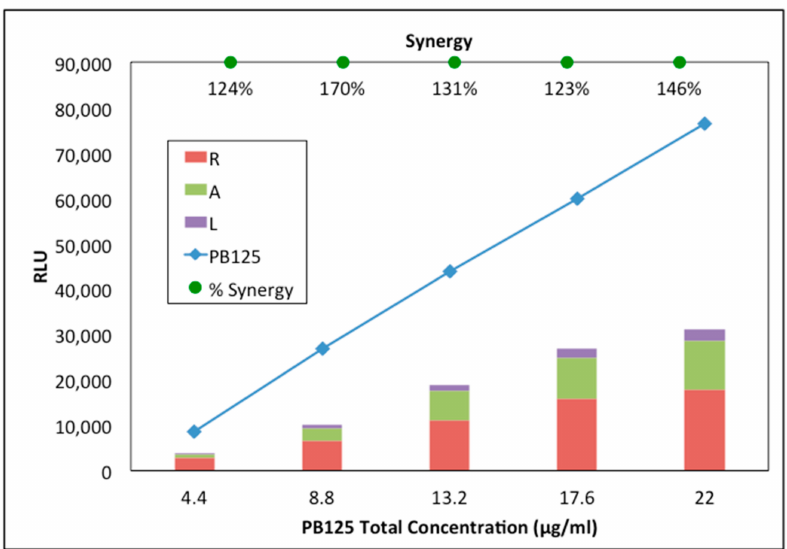
Figure 1. Synergistic activation of the Nrf2 pathway by the components in PB125. Synergy between the components of PB125 was observed measuring the relative light units (RLU) of chemiluminescence observed with added luciferin after ARE-driven luciferase gene expression was induced by treatment with range of concentrations of PB125 in the HepG2 (human liver) cancer cell line stably transfected with an ARE-driven luciferase gene as a promoter-reporter construct [84]. The individual contributions of the rosemary (R), ashwagandha (A), and luteolin (L) at the same concentration as in the 15:5:2 by mass combination of the same ingredients did not add (stacked bars) to as high of an RLU reading (Nrf2-dependent expression of the luciferase gene) as when cells were treated with the same amounts combined ( p <